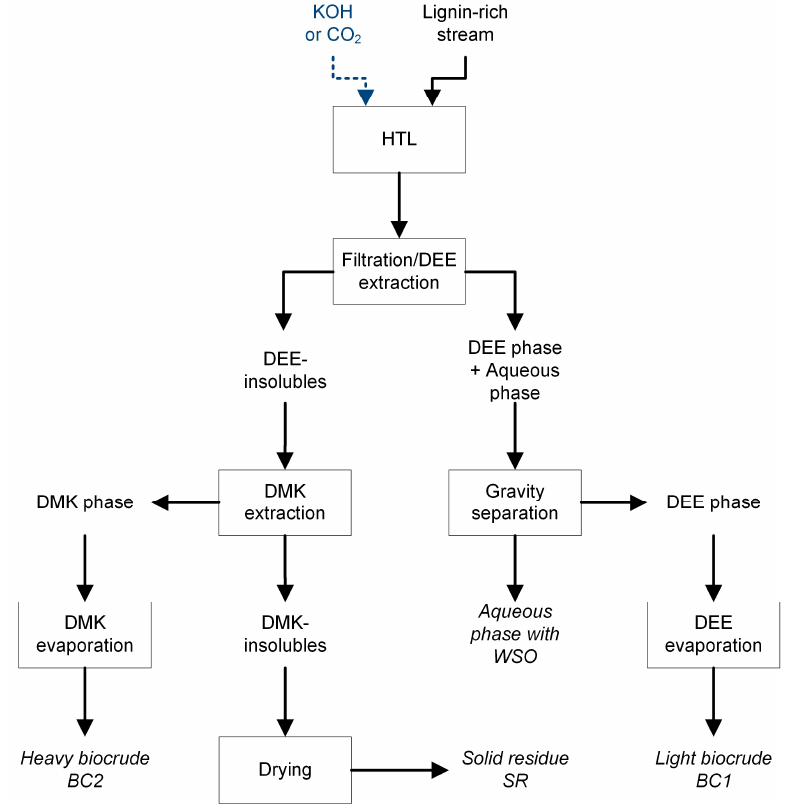
Figure 1. Extraction procedure for hydrothermal liquefaction (HTL) products recovery (Procedure 1).